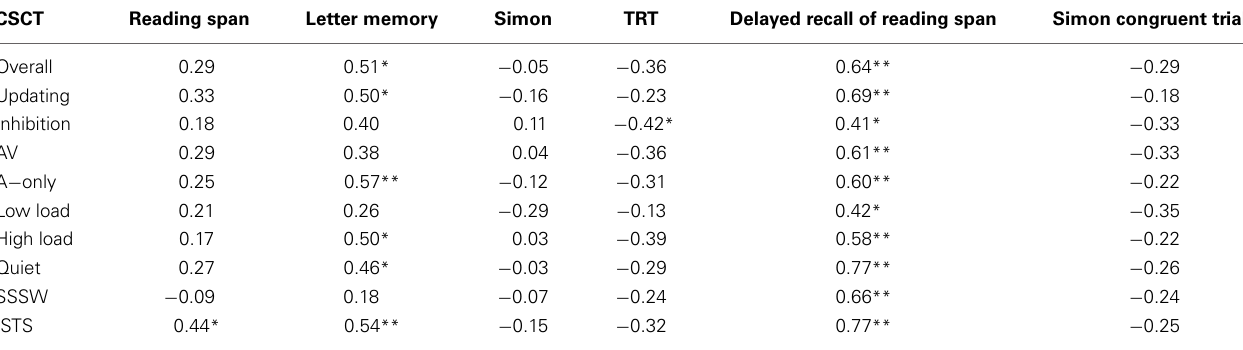
Table 3 | Coefficients of correlations (Pearson’s r) between factorwise CSCT scores and cognitive test scores.